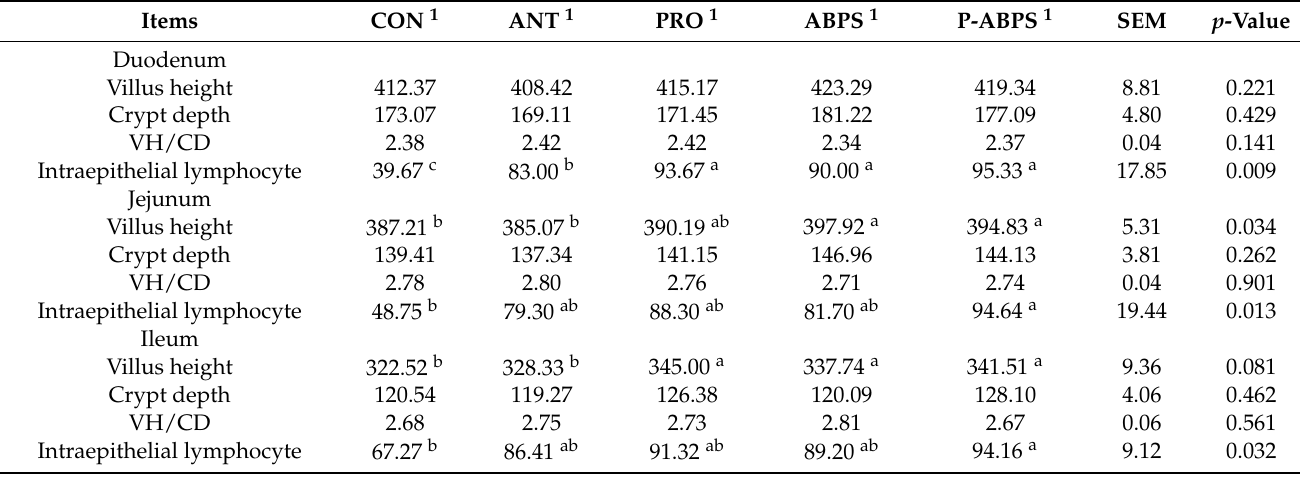
Table 5. Effects of probiotics and Achyranthes bidentata polysaccharides on small intestinal morphology and intraepithelial lymphocyte in piglets.